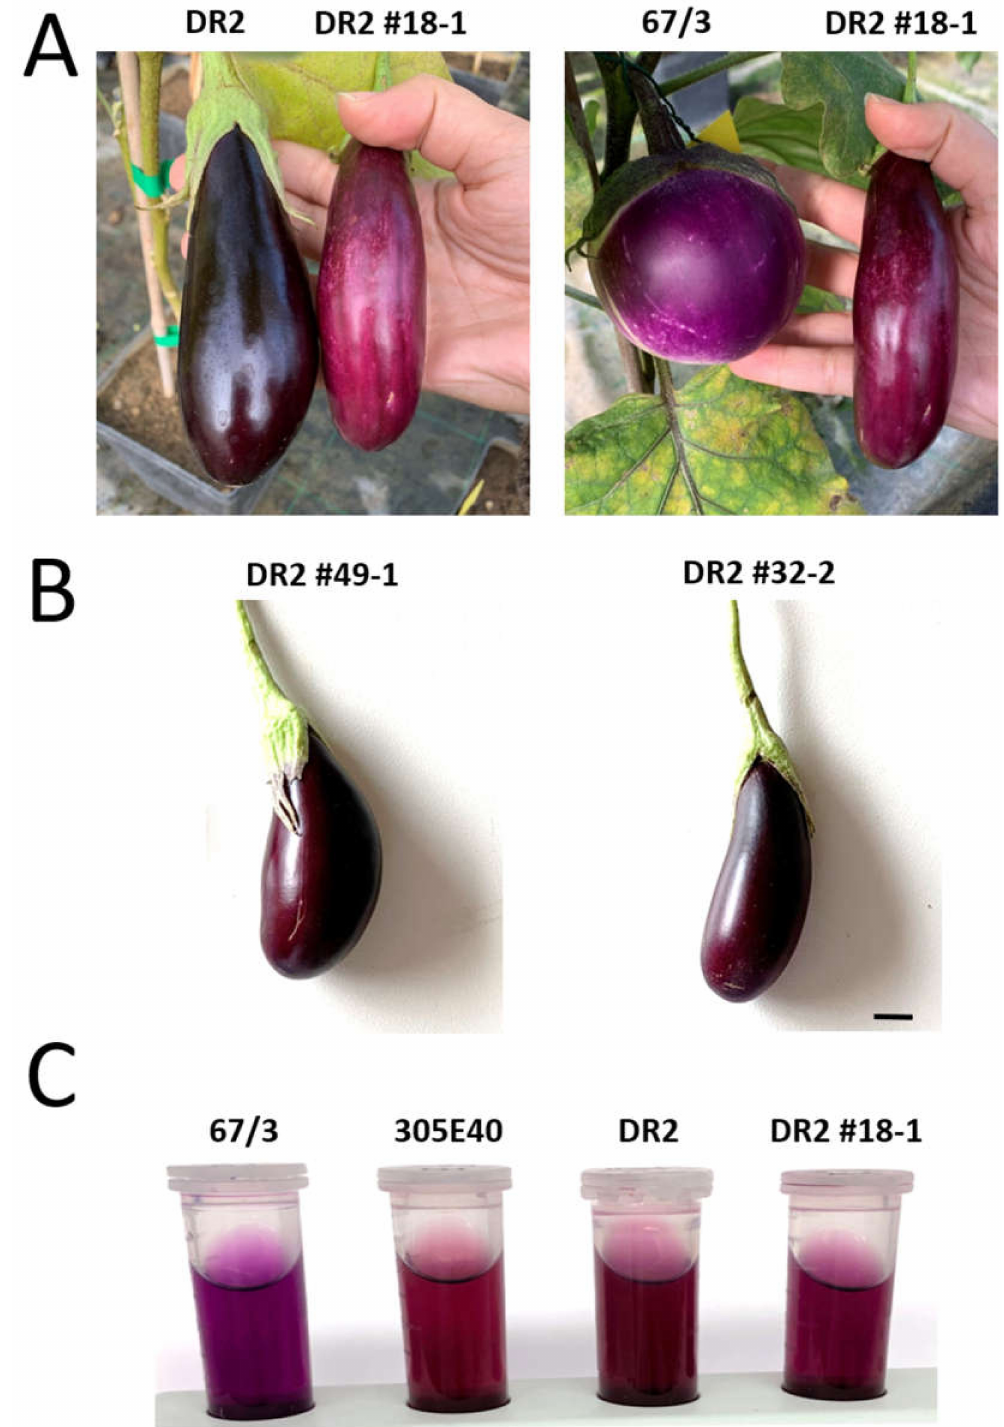
Figure 5. Peel color of p35S:SmelAAT fruits. ( A ) Wild-type DR2 and ‘67/3’ fruits compared with a fruit of line ‘DR2’ #18-1. ( B ) Fruits of two other transformed lines ‘DR2’ #49-1 and ‘DR2’ #32-2. ( C ) Comparison of ethanol anthocyanin extracts obtained from fruit peel of ‘67/3’, ‘305E40’, DR2, and line ‘DR2’ #18-1. In ( B ), scale bar = 1